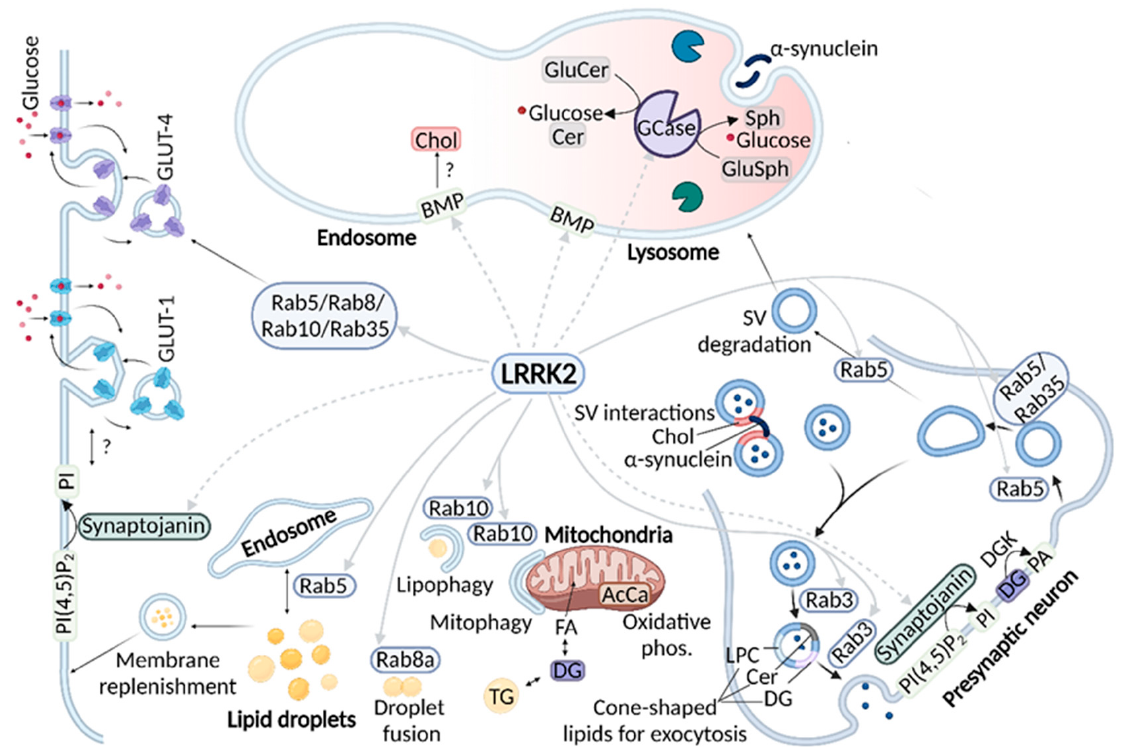
Figure 3. Summary of LRRK2 functions which impact lipids. Solid grey arrows represent direct phosphorylation by LRRK2 and dashed grey lines indicate a possible indirect or direct effect by LRRK2 through an unresolved mechanism of action. Synaptojanin-1 is a putative LRRK2 substrate that dephosphorylates phospholipid at the cell membrane, which is important for synaptic vesicle recycling and also insertion of GLUT-1 in the plasma membrane. Rab proteins phosphorylated by LRRK2 are also involved in recycling membrane receptors such as GLUT-4. Rabs are also involved in the trafficking of synaptic vesicles in vesicle recycling or degradation pathways. In addition, Rabs are involved in lipid droplet fusion, autophagy and transport of lipids from droplets to the cell membrane. Lipid droplets are also a reservoir for substrates important for mitochondrial oxidative phosphorylation. LRRK2 affects the endolysosomal lipid BMP, which in turn appears to affect endolysosomal cholesterol levels. LRRK2 may also have an effect on GCase activity and the levels of GCase substrates and metabolites. PI(4,5)P 2 = phosphatidylinositol 4,5-bisphosphate, PI = phosphatidylinositol, Chol = cholesterol, BMP = bis(monoacylglycerol) phosphate, GluCer = glucosylceramide, Cer = ceramide, GalCer = galactosylceramide, Sph = sphingosine, GluSph = glucosylsphingosine, SV = synaptic vesicle, LPC = lysophosphatidylcholine, DG = diacylglycerol, PA = phosphatidic acid, FA = fatty acid, AcCa = acylcarnitine, phos = phosphorylation. Created with BioRender.com (accessed on 26 Oct 2022).